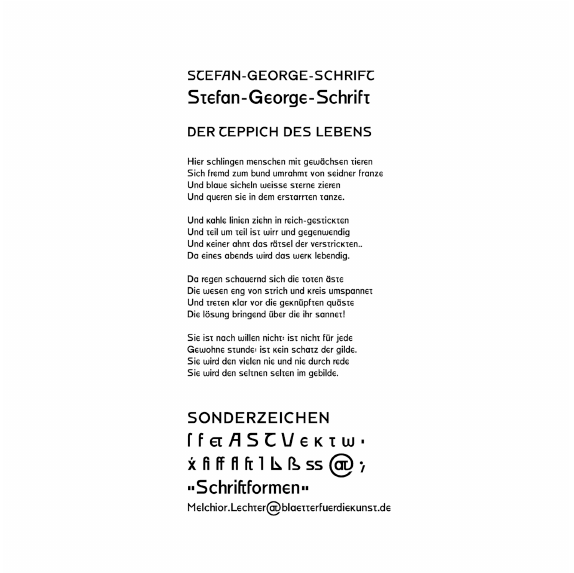
Figure 5. Digitaly reconstructed typeface of Stefan George, Ro- land Reuß’s (2003)